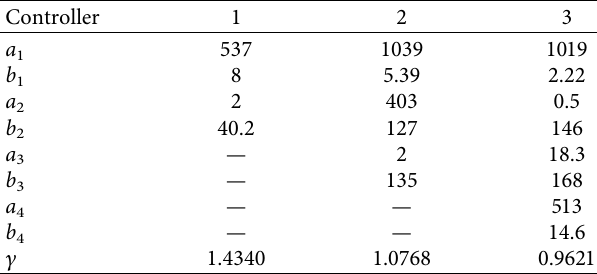
Table 3: Controllers design